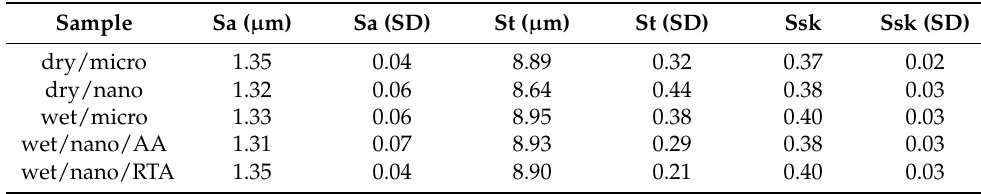
Table 1. Surface roughness measures.